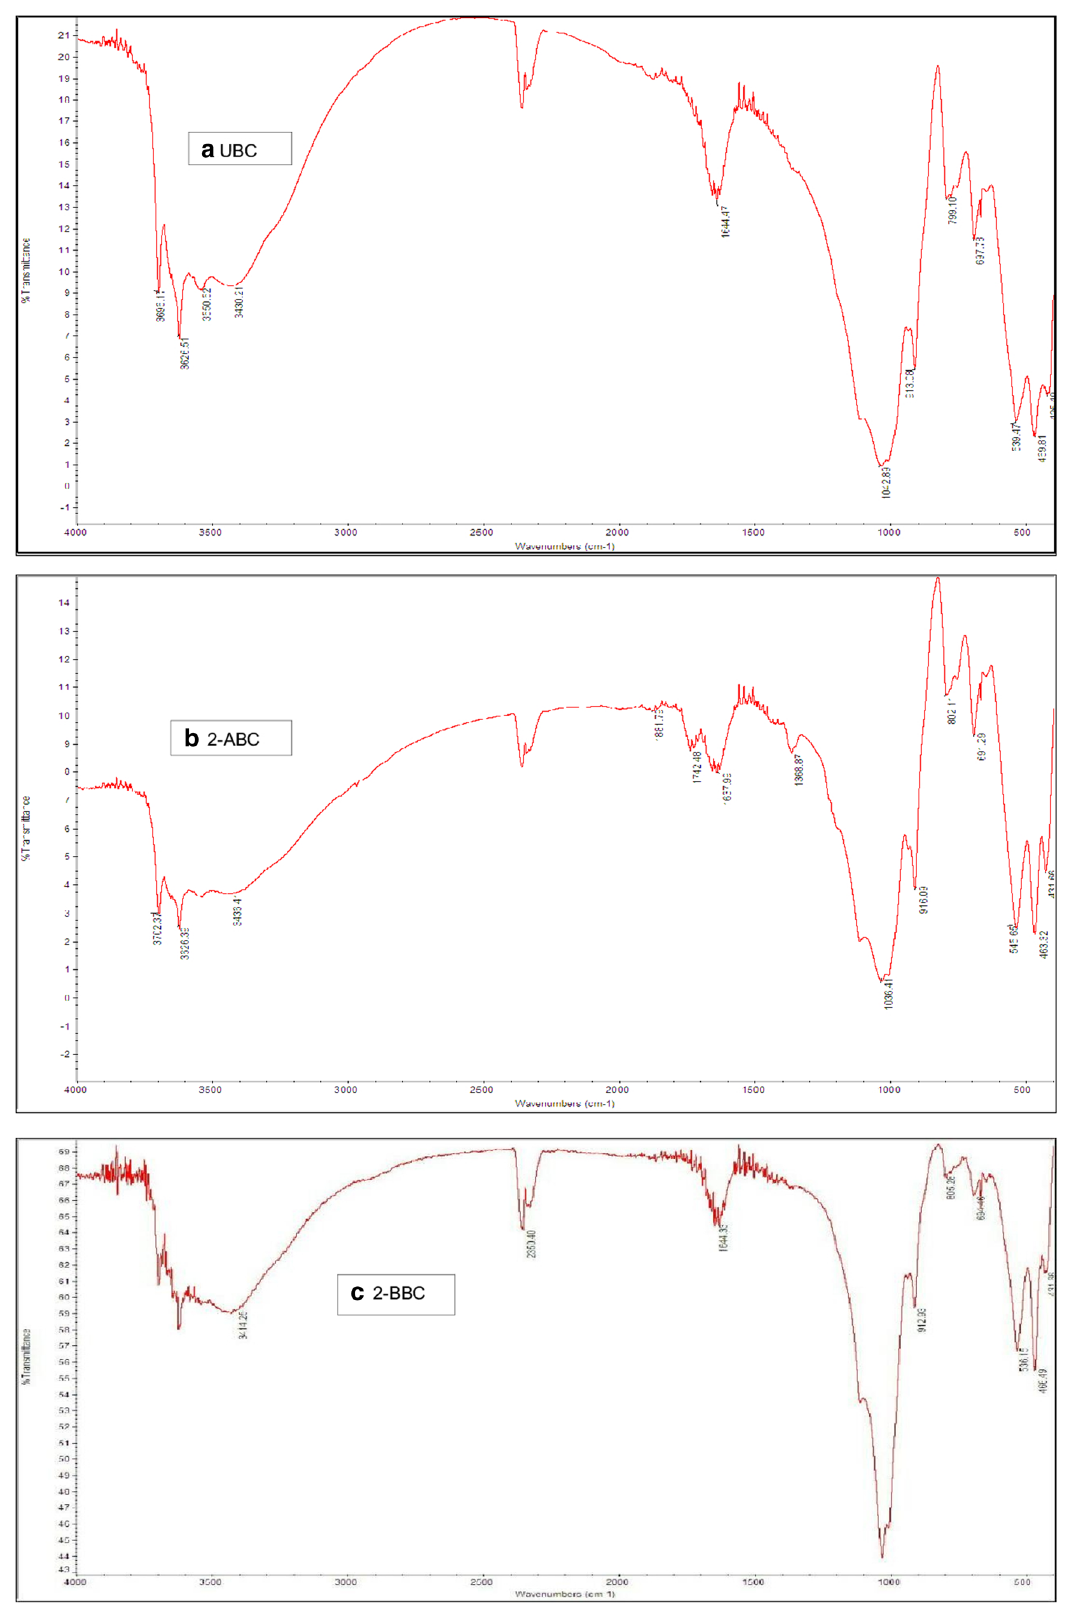
Fig. 2 FTIR spectra of a UBC, b 2-ABC, c 2-BBC, d UKC, e 2-AKC and f 2-BKC,